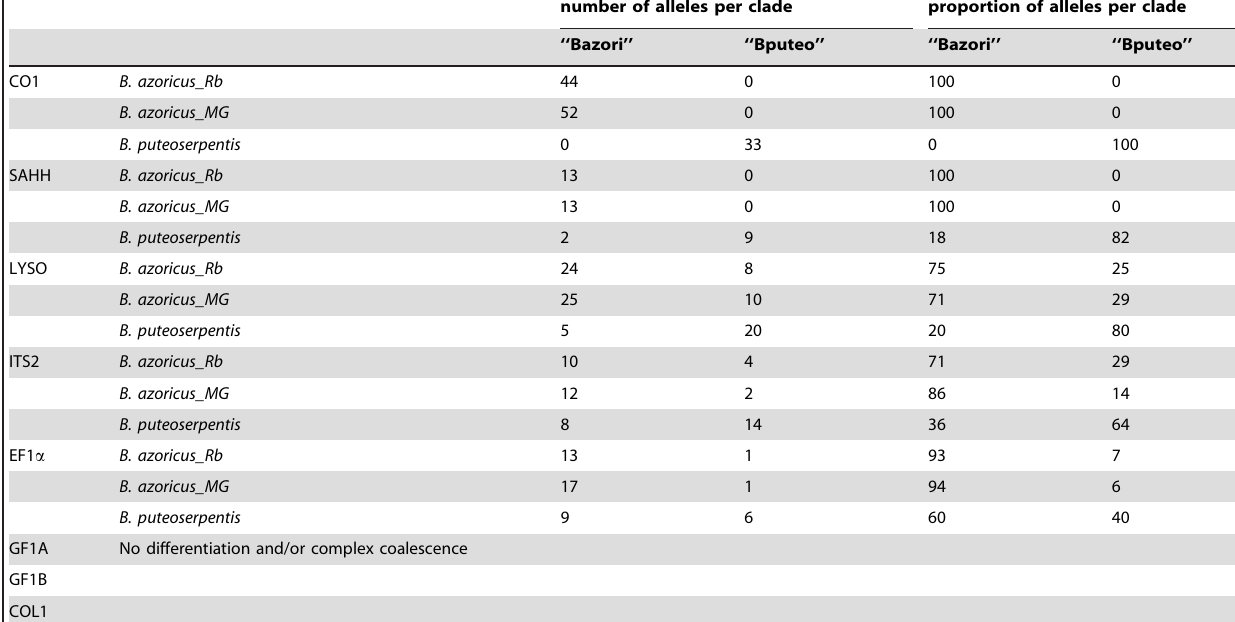
Table 3. Distribution of alleles.